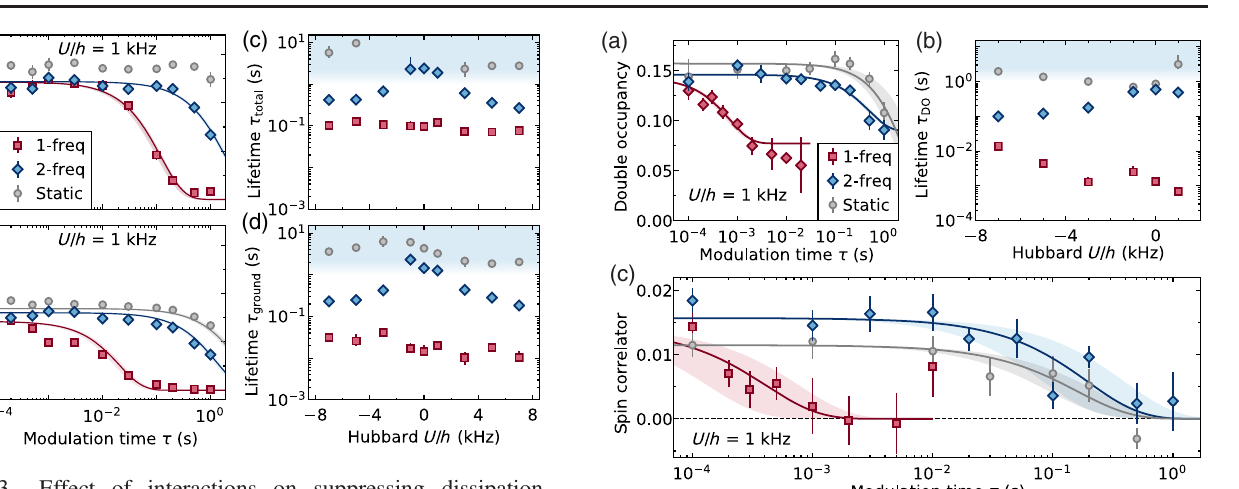
FIG. 3. Effect of interactions on suppressing dissipation. Measured total atom number N (a) and ground-band atom total FIG. 4. Suppressing dissipation in the strongly correlated number N (b) as a function of the modulation time, to which ground Fermi-Hubbard model. (a) Measured double occupancy as a an exponential decay is fitted (lines). While a single Floquet drive function of the modulation time. Double occupancy is the fraction leads to strong atom loss and depopulation of the ground band via of atoms in doubly occupied lattice sites in the ground band. higher-band excitations (red points), the presence of the control When applying two-frequency control (blue), the level of double drive at 2 ω (blue) cancels this dissipation mechanism. (c),(d) occupancy remains almost unchanged up to 1 s, similar to the Resulting 1 =e -lifetimes of the total atom number [ τ , (c)] and total static case (gray). (b) Fitted exponential lifetimes of double ground-band population [ τ , (d)] as a function of Hubbard U . ground occupancy τ as a function of Hubbard U . For weak and Since the longest measurement time is 1 s, fitted lifetimes longer DO intermediate interactions, the control method (blue) restores the than this value can be unreliable (blue shaded area). Data points lifetime of double occupancy almost to the static value (gray). We in (a),(b) show the mean and standard error of three individual restrict this measurement to values of Hubbard U=h ≤ 1 kHz as measurements, whereas the points in (c),(d) result from a least- the initial value of double occupancy for strong repulsive squares fit. The shaded areas in (a),(b) and the error bars in (c),(d) interactions becomes too low to reliably extract a lifetime. show the estimated uncertainty of the fitted value via boot- (c) Tracing the nearest-neighbor spin correlator with modulation strapping (Appendix C). time for U=h ¼ 1 kHz in the presence of the control drive (blue), compared to the single-frequency case (red). The static reference values are plotted in gray. Data points in (a) and (c) show the mean and standard error of at least three and ten individual measurements, respectively, whereas the plotted lifetimes in (b) result from a least-squares fit. The shaded areas in (a),(c) and the error bars in (b) show the estimated uncertainty of the fitted value via bootstrapping (Appendix C). Since the longest measurement time is 1 s, fitted lifetimes longer than this value can be unreliable [blue shaded area in